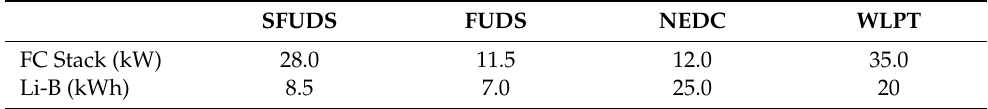
Table 3. H-ESS design solutions (Psplit1): δ = 1.